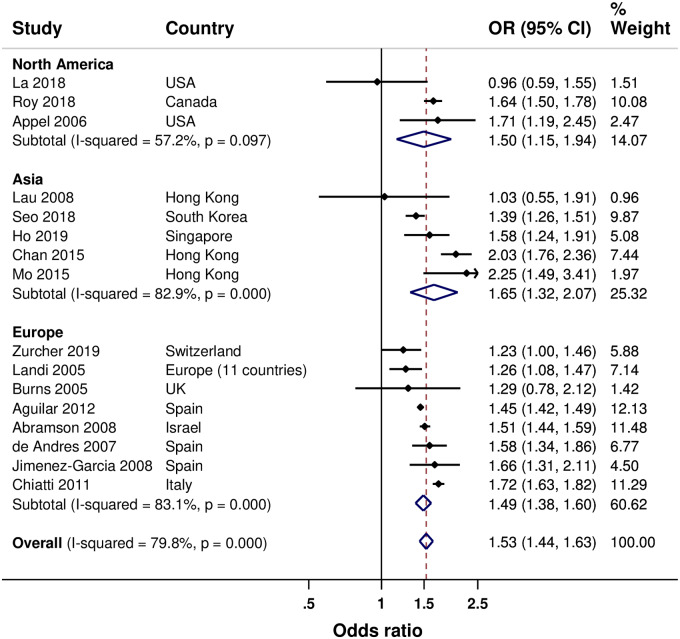
Forest plot of the association between chronic disease and SIV uptake (having versus not having a chronic disease).